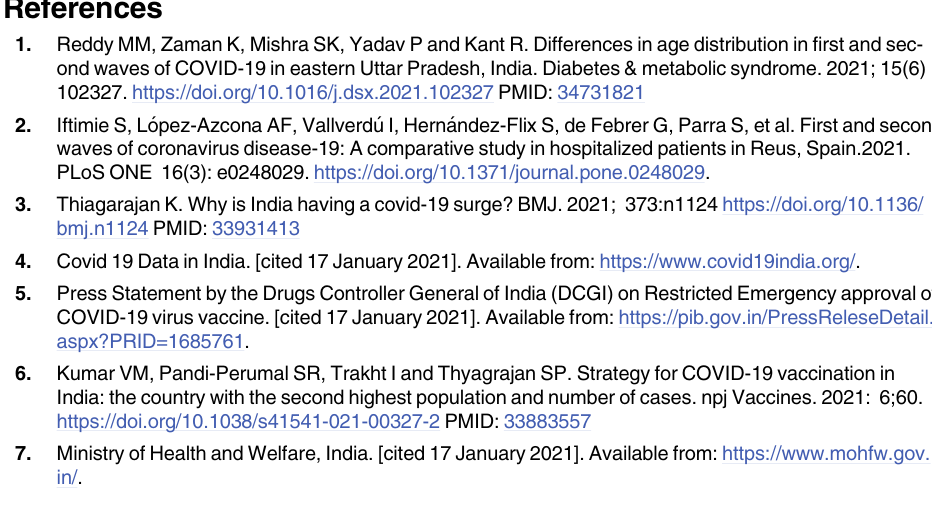
S2 Table. Factors associated with COVID-19 vaccination. S3 Table. Infection distribution based on participant designation. S4 Table. Vaccination distribution based on participant